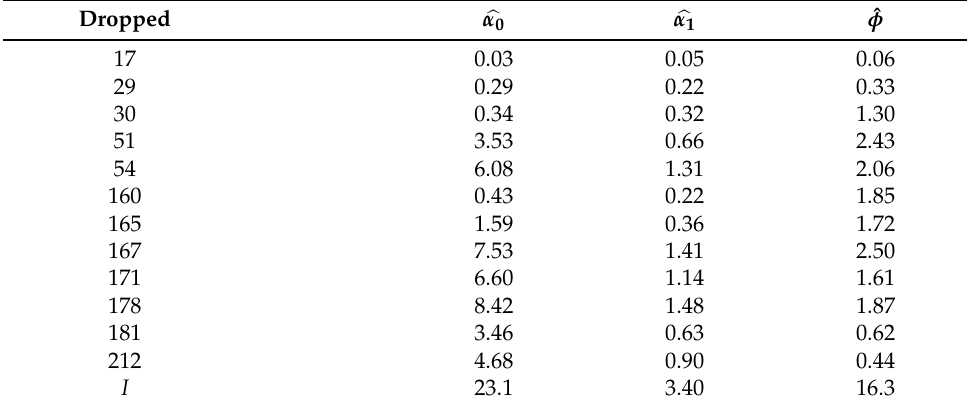
Table 6. Relative changes (%) in MPLE (cid:98) α 0 , (cid:98) α 1 and ˆ φ of Student-t